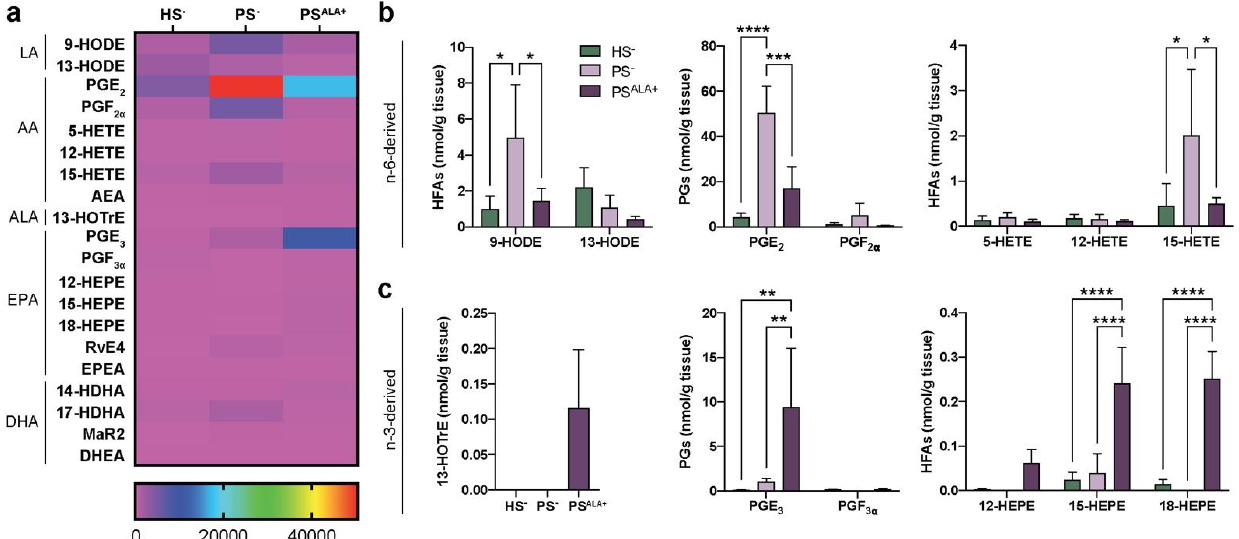
Figure 2. Levels of lipid mediators in the dermis. ( a ) Heatmap of bioactive lipid mediators found in the dermis of the skin substitutes as determined by targeted LC-MS/MS (N = 3). ( b ) n-6-derived and ( c ) n-3-derived bioactive lipid mediators from ( a ) that were the most differentially measured between HS − , PS − , and PS ALA+ dermis. Statistical significance was determined in ( b , c ) using